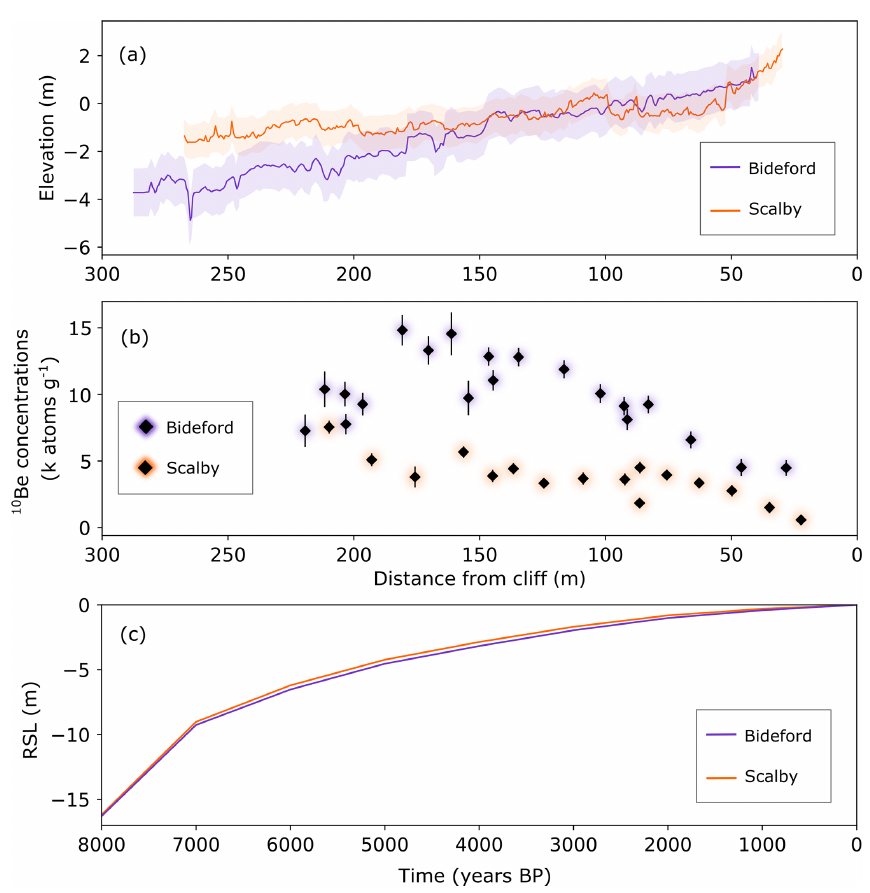
Figure 2. Measured topographic profile (a) and 10 Be concentration data (b) from the Bideford and Scalby shore platform rock coast sites. Average elevation in the swath profile is shown by the solid line, and uncertainty for the topographic profile shown by the shaded area is the sum of the standard error from a linear regression of the topographic swath profile and the estimated spatial accuracy of the UAV imagery (a) . 10 Be concentration values (b) are corrected for chemistry background using process blank samples and inherited 10 Be using shielded sea cave or cliff samples. Errors are propagated in quadrature, allowing for calculation of corrected 10 Be concentrations (see Sect. 3.1). An RSL curve of absolute RSL elevations taken from a GIA model (Bradley et al., 2011) is shown from 8000 years BP to the present day (c)